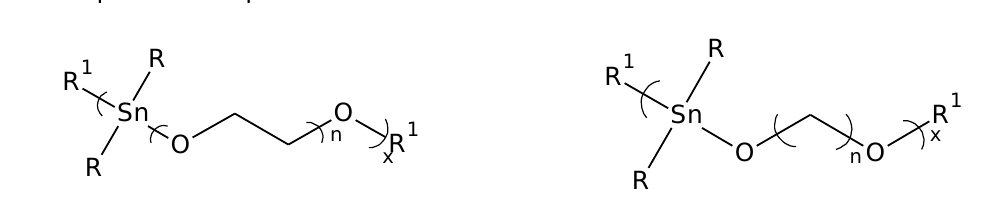
Figure 1. Repeat unit for the polymers derived from the reaction of organotin dihalides with various ethylene glycols (left) and with methylene oxide diols (right) where R is butyl and R 1 represents simple chain